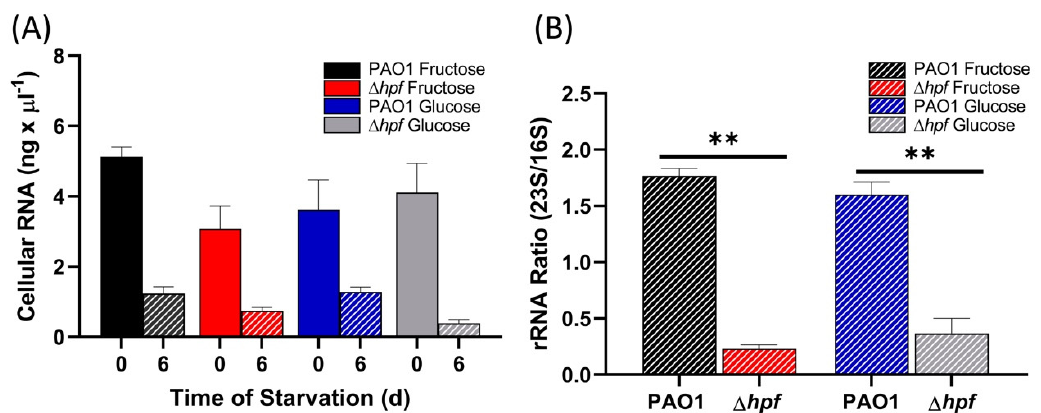
Figure 10. RNA integrity of P. aeruginosa cultured in MOPS-glucose or MOPS-fructose to O.D. 600 = 1.0, then starved for six days. ( A ) Total cellular RNA levels prior to starvation and after 6 d of starvation. ( B ) 23S / 16S rRNA ratios of strains pre-cultured in MOPS-glucose or MOPS-fructose, then starved for 6 d. Data show the mean and standard error of three independent biological replicates. Asterisks (**) for 23S / 16S ratio shows significant di ff erence between 0 and 6 d ( p <